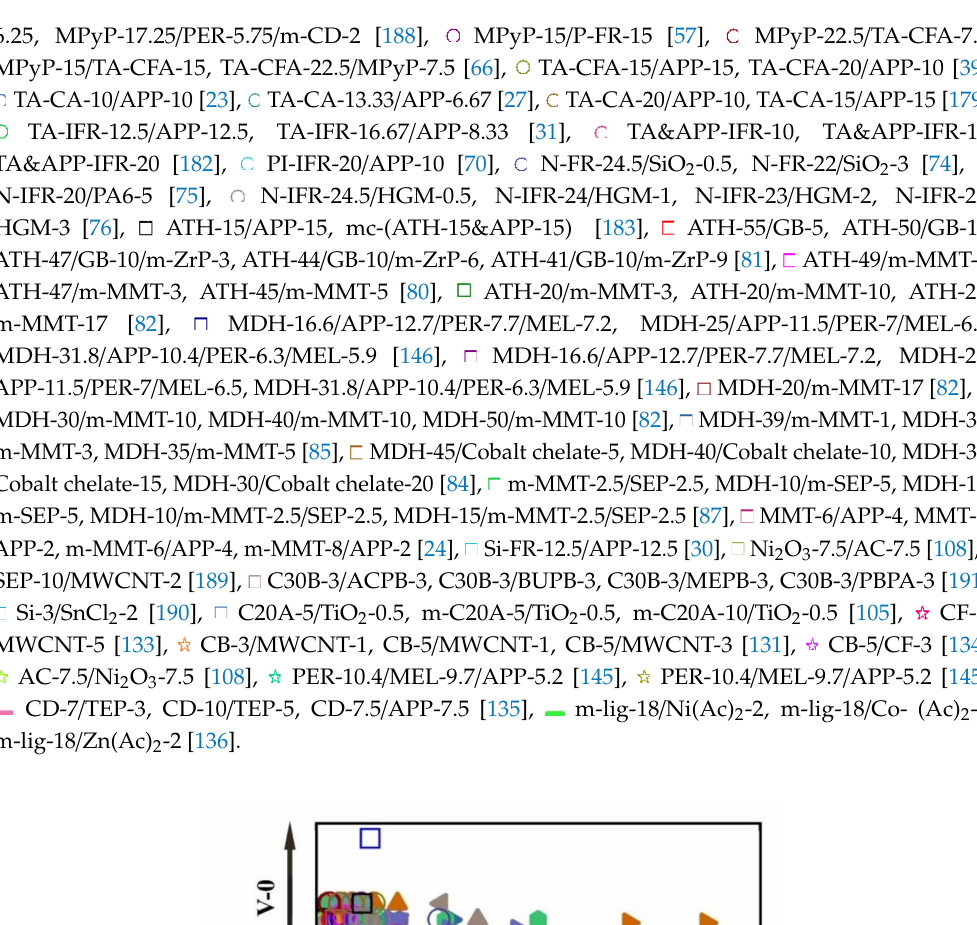
Figure 16. FRI values versus UL‐94 test results. Symbols are indicative of combination of flame retardant (FR) additives used in PP. The vertical intervals in each category, i.e., V‐0, V‐1, V‐2, and NR, are schematically representative of the amount of additive used. For example, two data distinguished by different symbols having the same or very close FRI values (horizontal quantity) in a given category (e.g., V‐1), may have different vertical quantities, e.g., both reveal V‐1 behavior in UL‐94 test, but the upper contains more FR in PP.